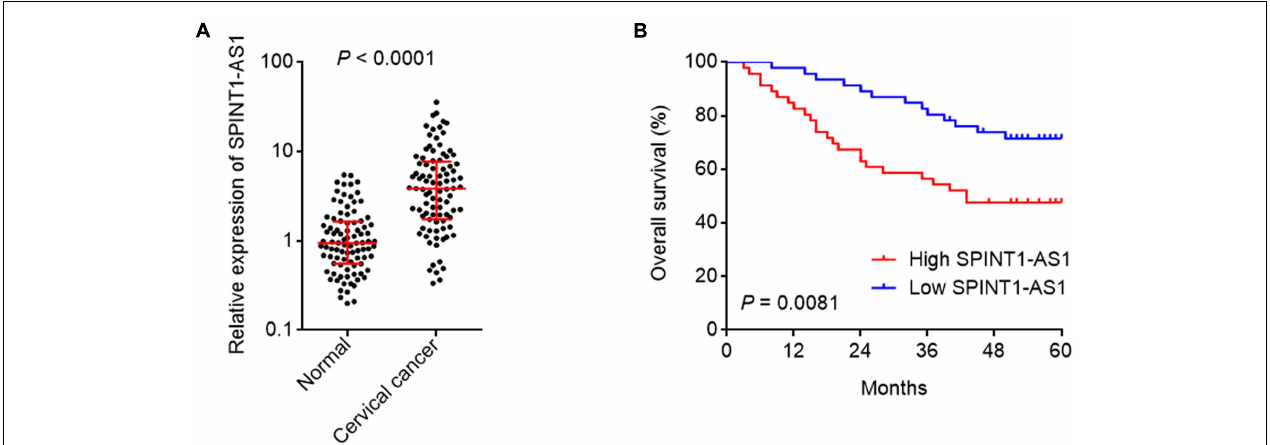
FIGURE 3 | SPINT1-AS1 was increased in cervical cancer tissues and associated with poor prognosis of cervical cancer patients. (A) SPINT1-AS1 expression in 92 pairs of cervical cancer tissues and adjacent normal cervical tissues was detected by qRT-PCR. Results are shown as median with interquartile range. P < 0.0001 by Wilcoxon matched-pairs signed rank test. (B) Kaplan-Meier analysis of the correlation between SPINT1-AS1 expression level and overall survival of these 92 cervical cancer cases. The median expression level of SPINT1-AS1 was used as the cutoff. P = 0.0081 by log-rank test.